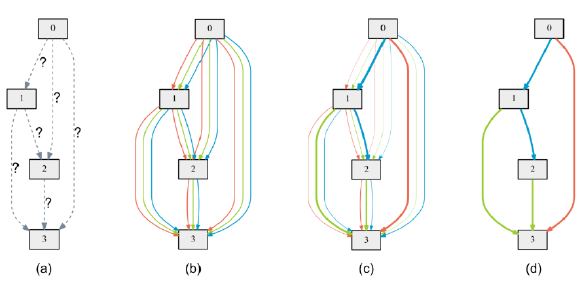
Figure 3. DARTS search strategy: Begins with every